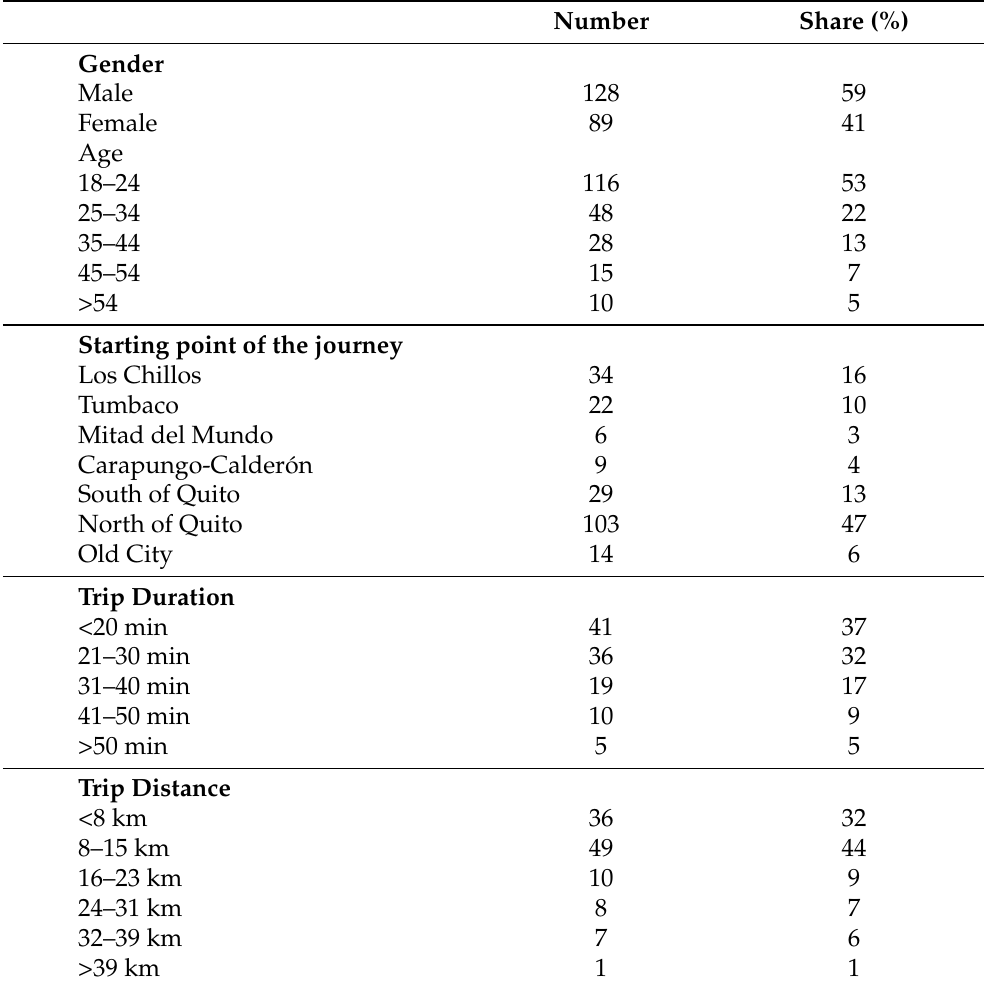
Table 1. Demographic summary of the